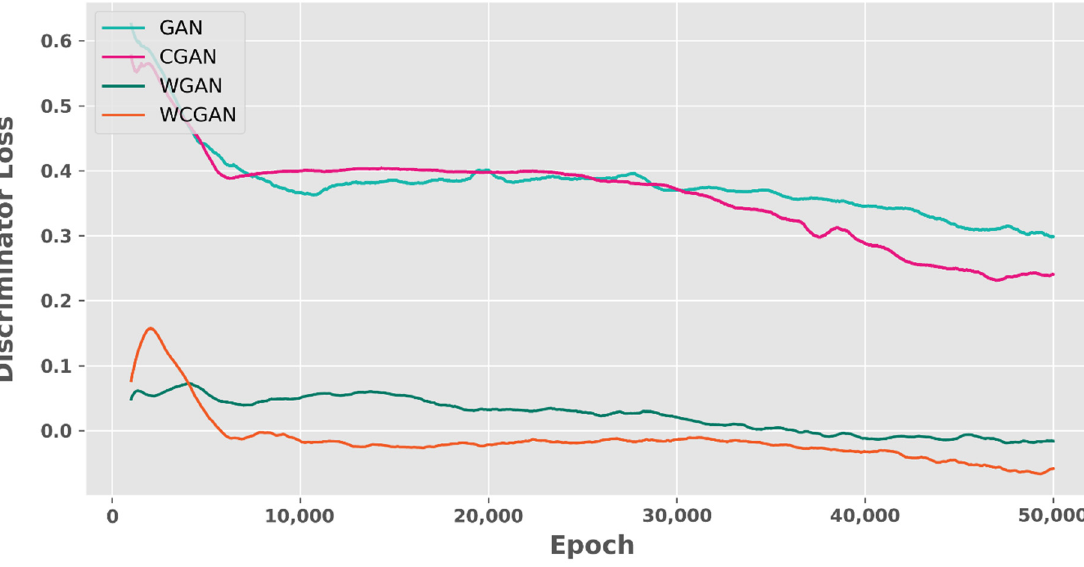
Figure 9. Presentation of how our best-performing WCGAN-based model learned to synthesize new generated samples based on real samples.